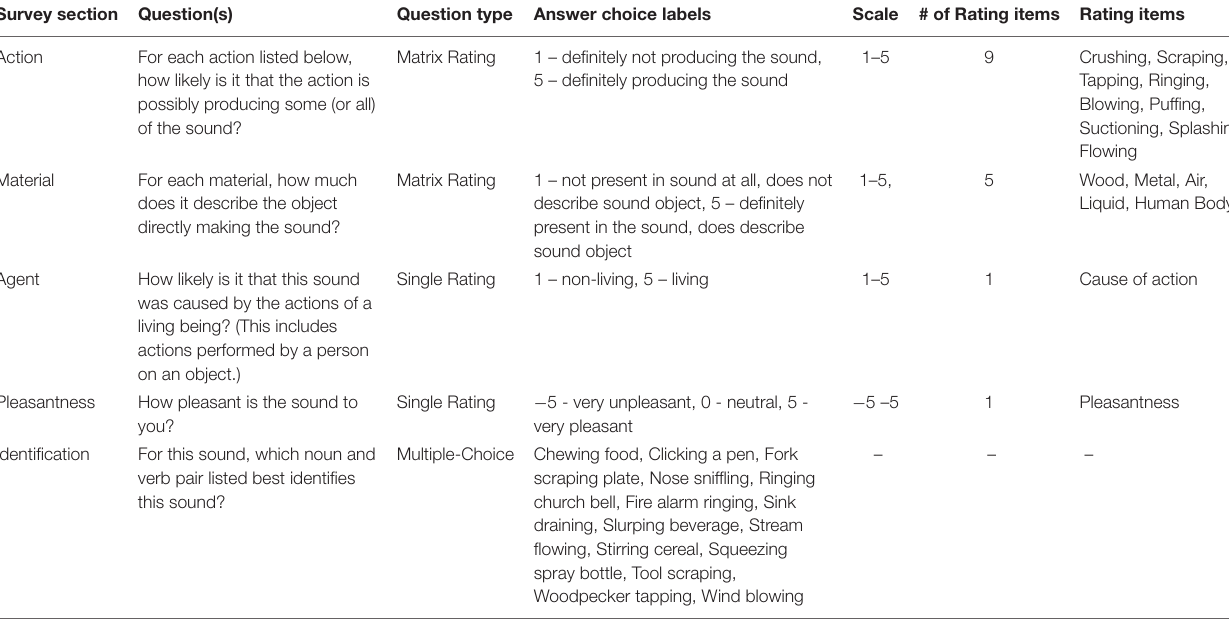
TABLE 2 | Main five survey sections of action, material, agent, pleasantness, and identification questions. Survey section